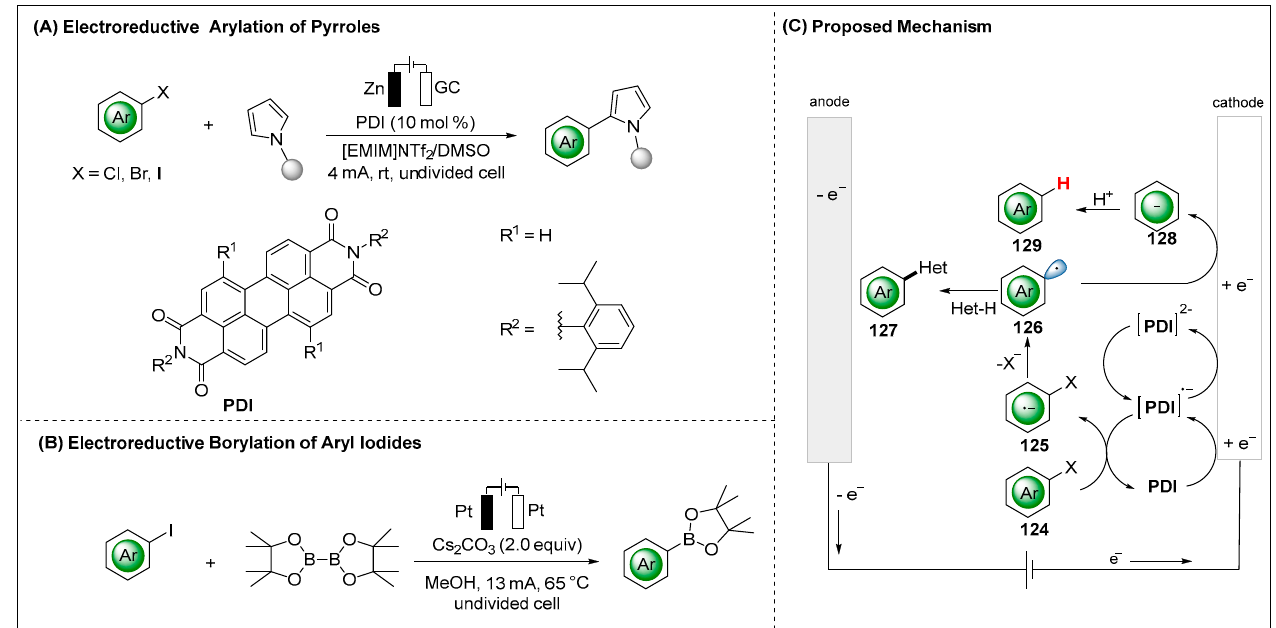
Figure 16. Electroreductive arylation and borylation of aryl halides.